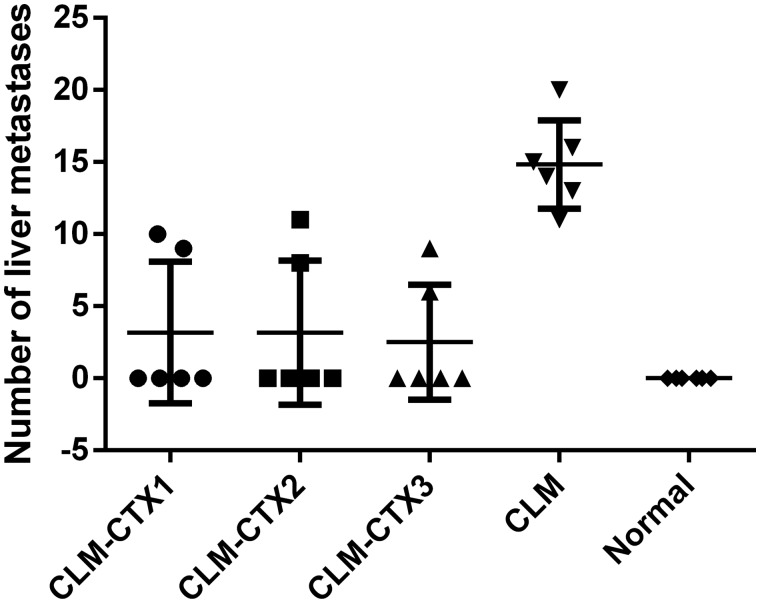
The number of mice that developed liver metastasis of colon cancer through splenic tumor-cell injection (5 × 104 CT26 cells) in different treatment groups. The liver metastasis of colon cancer was observed only in two of six mice in the CLM-CTX1, CLM-CTX2, and CLM-CTX3 groups. Macroscopic liver metastasis of colon cancer was observed in all mice in the CLM group. No macroscopic and microscopic liver metastases were observed in the normal group. Mice in the CLM-CTX1 group (n = 6) were intraperitoneally injected with CTX (20 mg/kg) post surgery immediately. Mice in the CLM-CTX2 group (n = 6) were intraperitoneally injected with CTX (20 mg/kg) on Days 0 and 7 post surgery. Mice in the CLM-CTX3 group (n = 6) were intraperitoneally injected with CTX (20 mg/kg) on Days 0, 7, and 14 post surgery. The mice of the liver metastasis only (CLM) group (n = 6) were not injected with CTX. CLM, colon-cancer liver metastasis; CLM-CTX, colon-cancer liver metastasis-cyclophosphamide; CTX, cyclophosphamide.